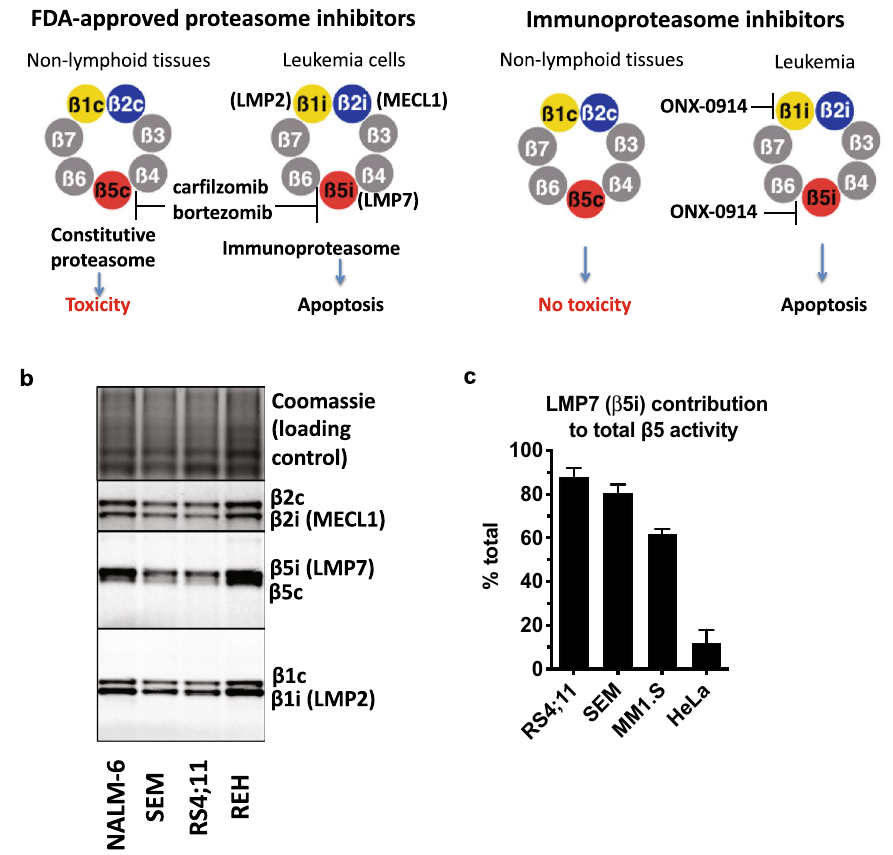
Figure 1. ALL cell lines express high levels of immunoproteasomes. ( a ) The principle of replacing FDA- approved proteasome inhibitors with immunoproteasome inhibitors for the treatment of ALL. Catalytic β-subunits of the proteasome are colored, non-catalytic β-subunits are gray. ( b ) Active proteasome subunits were labeled in cell extracts with proteasome-specific activity-based probes, resolved on SDS-PAGE, and detected by fluorescent imaging. Uncropped images of the gel, which also contain a second biological replicate, are presented in Fig. S1. The β5i/β5c image was stretched vertically to improve resolution between subunits. Subunit assignments are based on a pattern in HeLa cells (no immunoproteasomes) and inducibility of immunoproteasomes by interferon γ, which are shown in Fig. S2a, together with an additional biological replicate for SEM and RS4;11 cells. ( c ) To determine the contribution of LMP7 to the total activity of proteasome ß5 sites, cell extracts were treated with a highly specific LMP7 inhibitor LU-015i (5 μM, Fig. S2b) and cleavage of Suc-LLVY-amc was